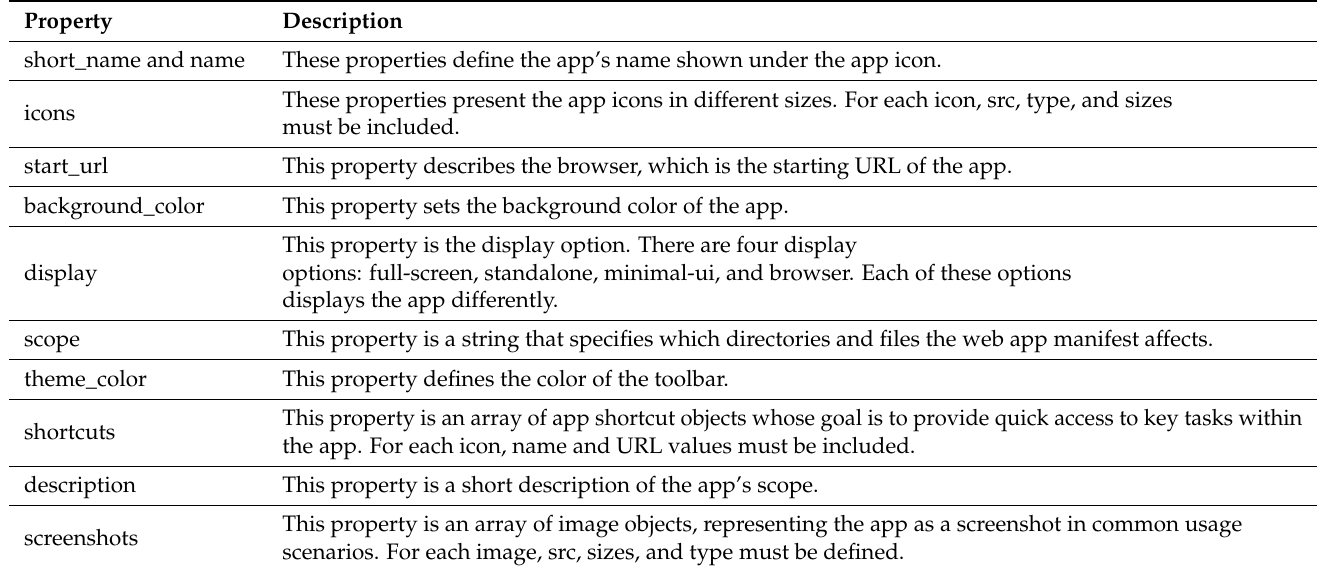
Table 1. Web manifest